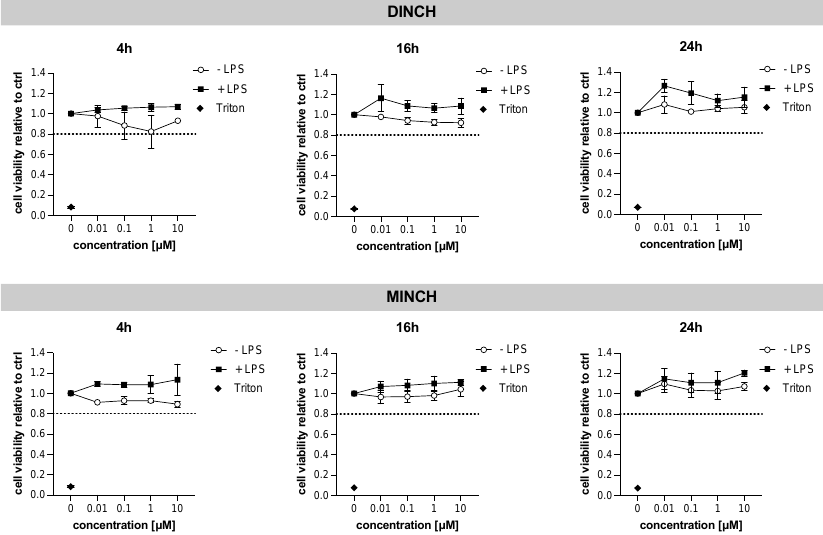
Figure 1. Effects of DINCH and MINCH on the cell viability of THP-1 M1-like macrophages. Differentiated THP-1 cells were treated with increasing concentrations of DINCH or MINCH for 4, 16, and 24 h, followed by MTS-Assay. Treatment with triton (0.01%) served as control reflecting minimal cell viability. Cell viability was determined relative to the control which contained equivalent amounts of vehicle solvent (0.01% MeOH, v/v ). A decrease in cell viability by 20% (IC 20 ) is indicated by a dotted line. Values are displayed as mean ± SD, n = 4.